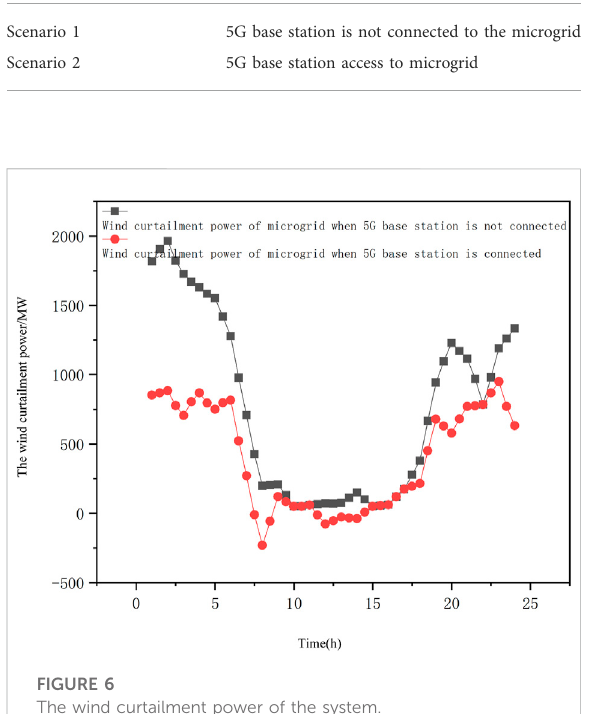
FIGURE 6 The wind curtailment power of the system.